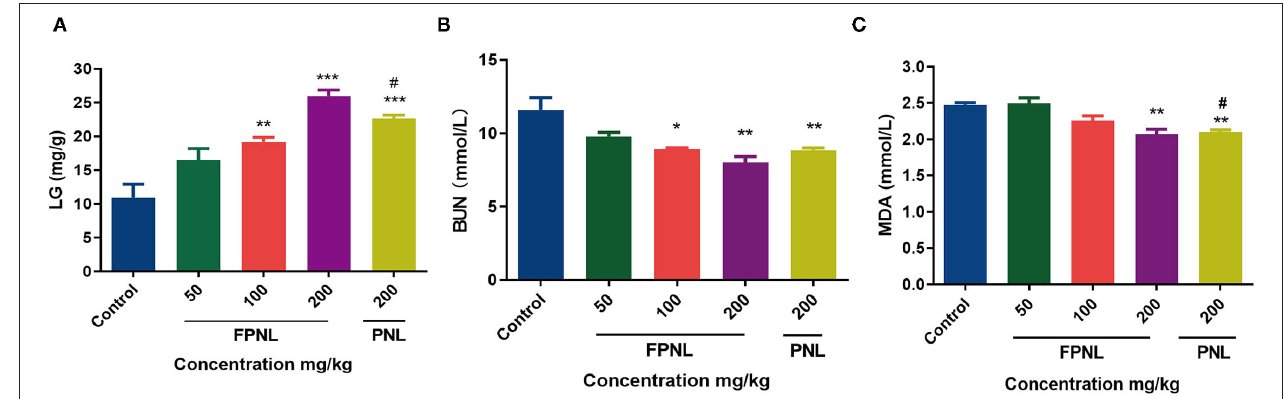
FIGURE 7 | Effect of fermented P. notoginseng leaves and P. notoginseng leaves on LG BUN, MDA level in serum. (A) The LG level in mice serum after swimming. (B) The BUN level in mice serum after swimming. (C) The MDA level in mice serum after swimming. Data are expressed as mean ± SEM from six independent